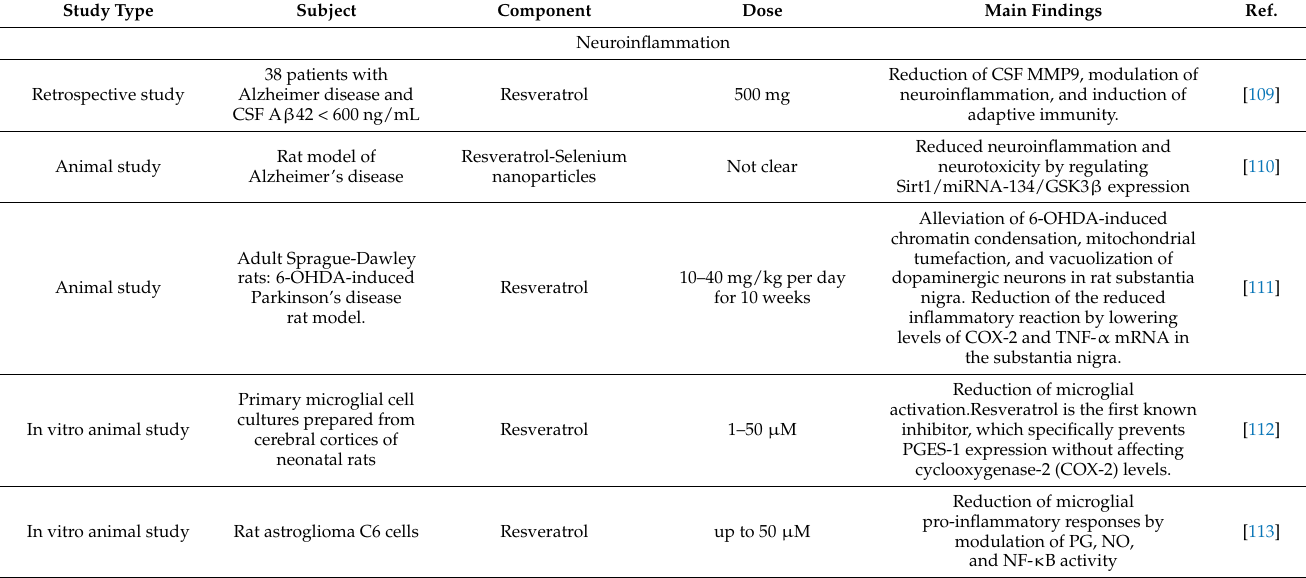
Table 1. Evidence on neuroprotective and cognitive role of resveratrol and hydroxytyrosol. AMPK, AMP-activated protein kinase; β A, beta amyloid, COX, cyclooxygenase; CSF, cerebrospinal fluid; ER β , estrogen receptor β ; ERK, extracellular signal-regulated kinase; LPS, lipopolysaccharide; MMP9, matrix metalloproteinase 9; NF- κ B, nuclear factor κ B; NO, nitric oxide, PGES-1, prostaglandin E synthase-1; TNF, tumor necrosis